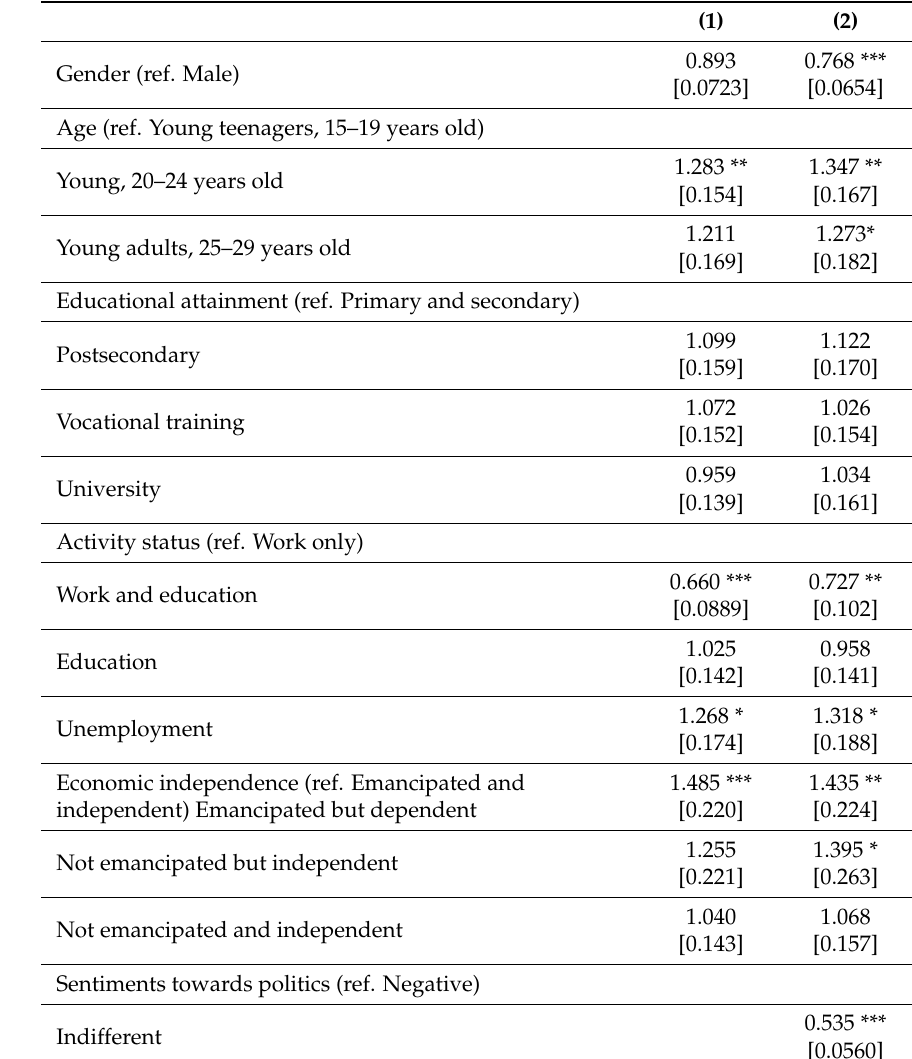
Table A5. Logistic regression estimates of political discontent. Odds